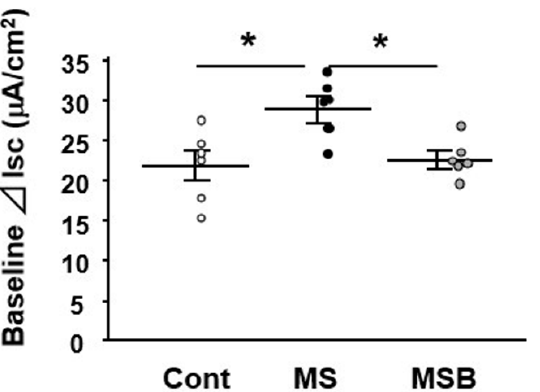
Figure 1. Effect of probiotic BBG9-1 on colonic permeability in MS rats. The macromolecular permeability in the colon tissues was evaluated using the Ussing chamber system. Results are expressed as mean ± SEM. Cont, control ( n = 6); MS, maternal separation ( n = 6); MSB, MS with BBG9-1 treatment ( n = 6). Significant differences between two groups at * p <